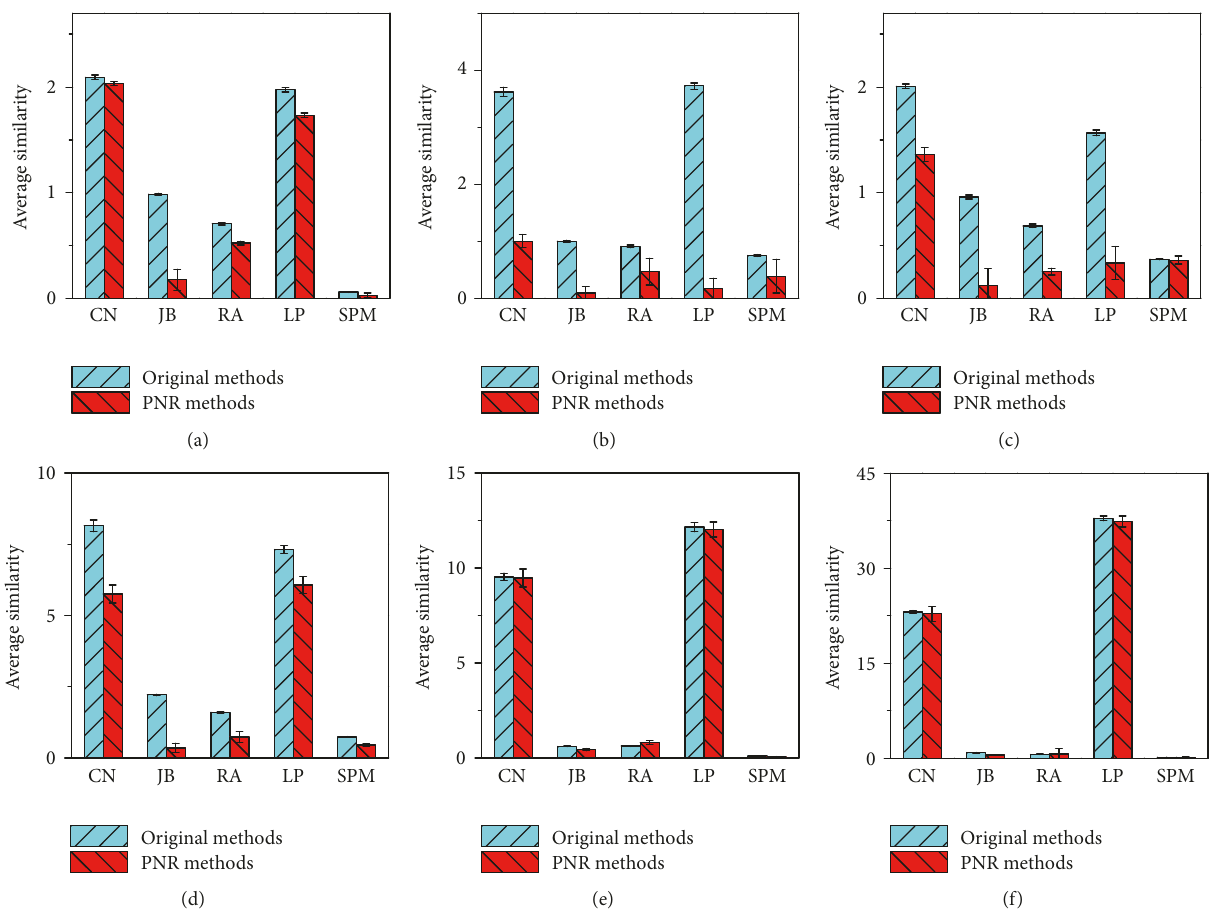
Figure 8: Comparison of average similarity of the PNR predicted is linked with that of the corresponding original methods for different networks. (a) Email network. (b) PDZBase network. (c) Euroad network. (d) Neural network. (e) Roundworm network. (f) USair network. Results are the average of 50 independent simulations. Our proposed framework reduces the average similarity on the whole, which indicates that more long-range links are predicted